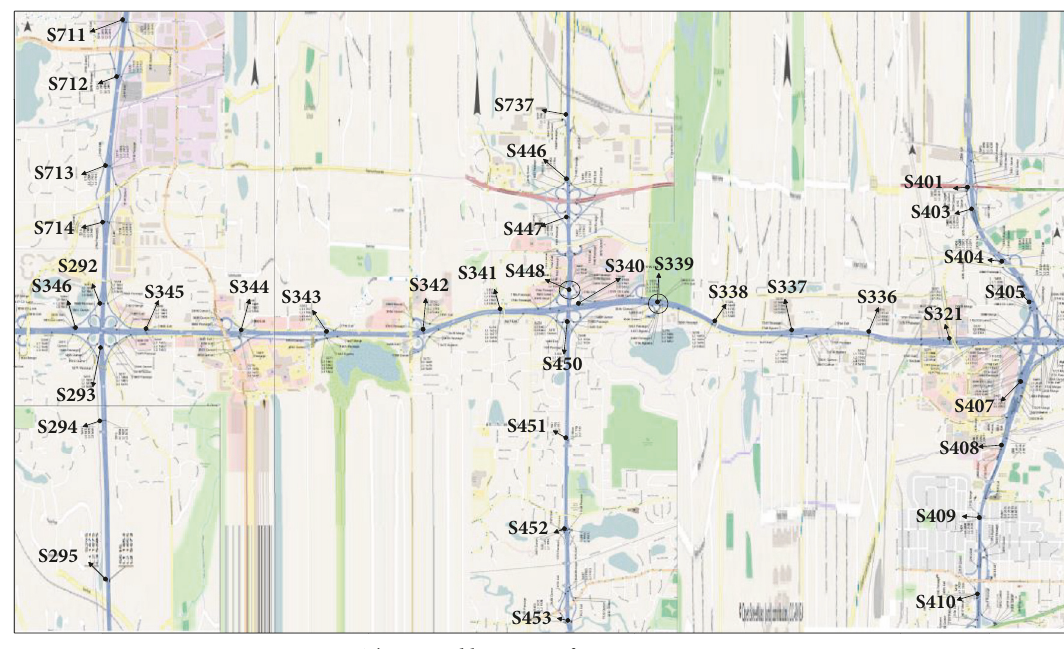
Figure 3: The ID and locations of stations in our experiment.